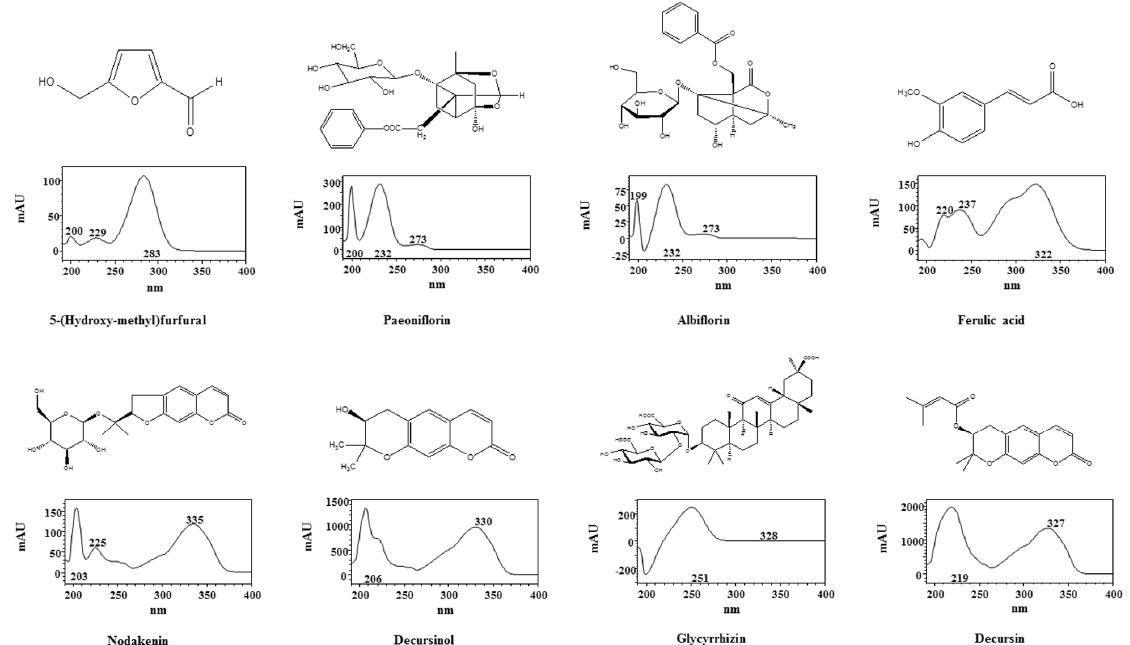
Figure 6. Chemical structures and HPLC DAD spectra of the main constituents of